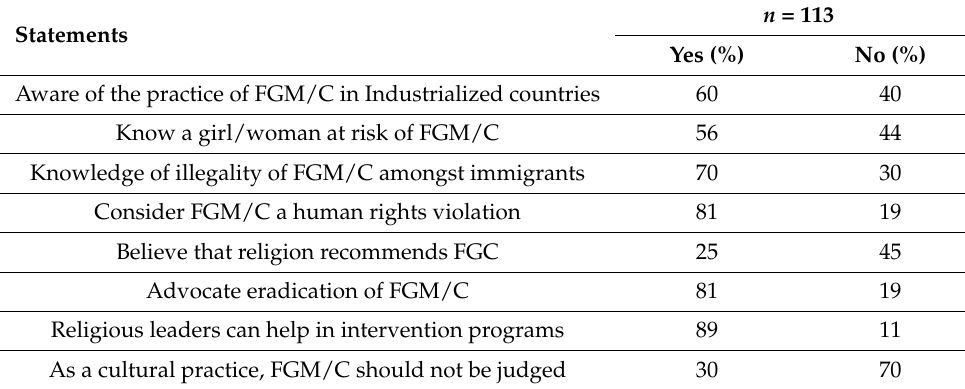
Table 1. Responses about FGM/C in the